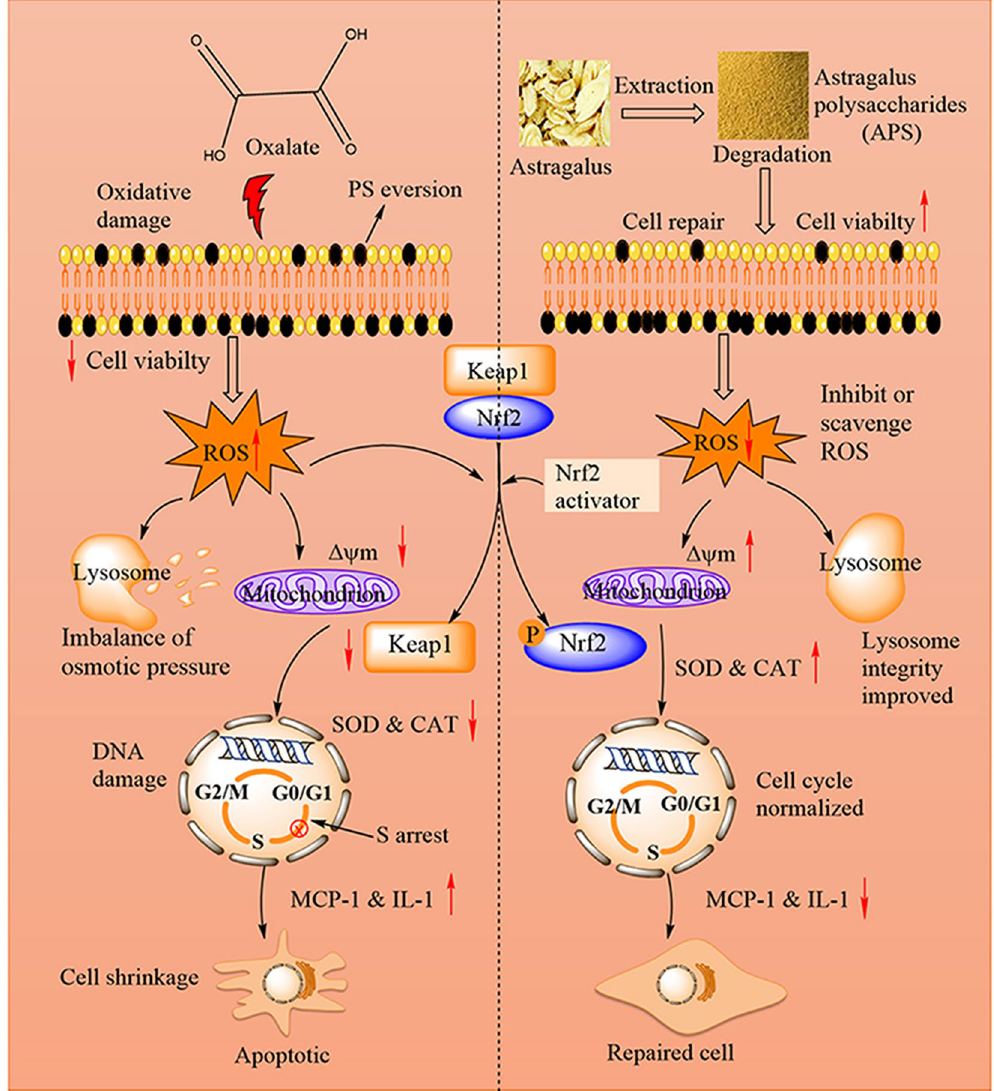
Figure 12. Repair schematic diagram of APSs with different Mws on damaged HK-2